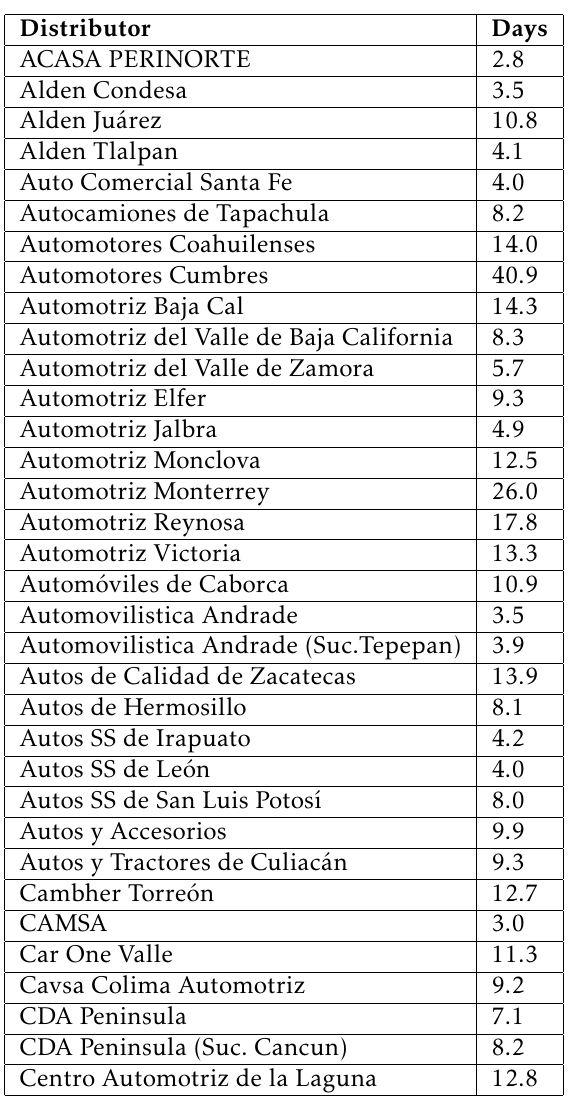
Table 8. Average days of